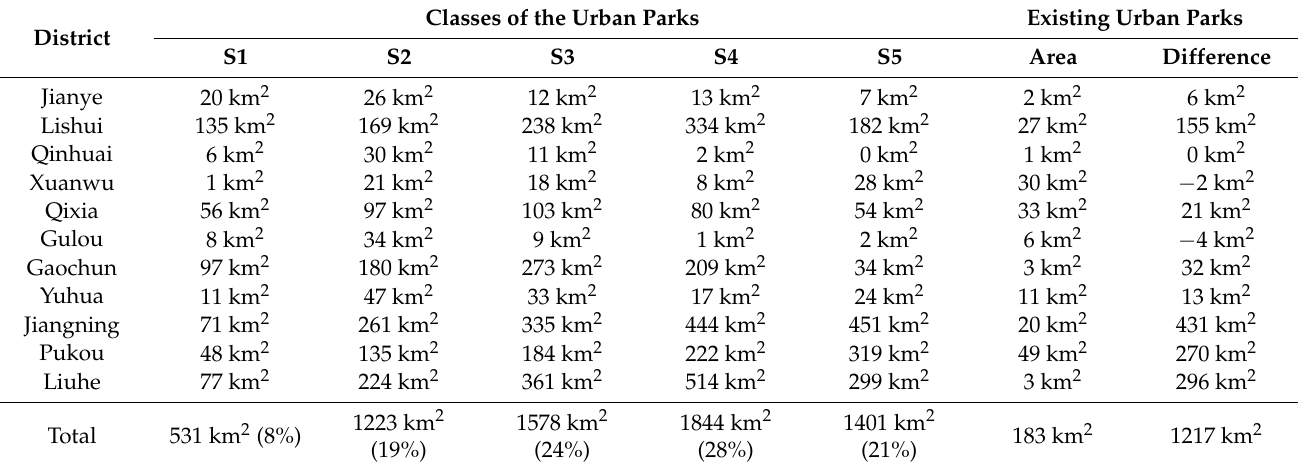
Table 4. The ecological suitability of the site area for urban parks in Nanjing,